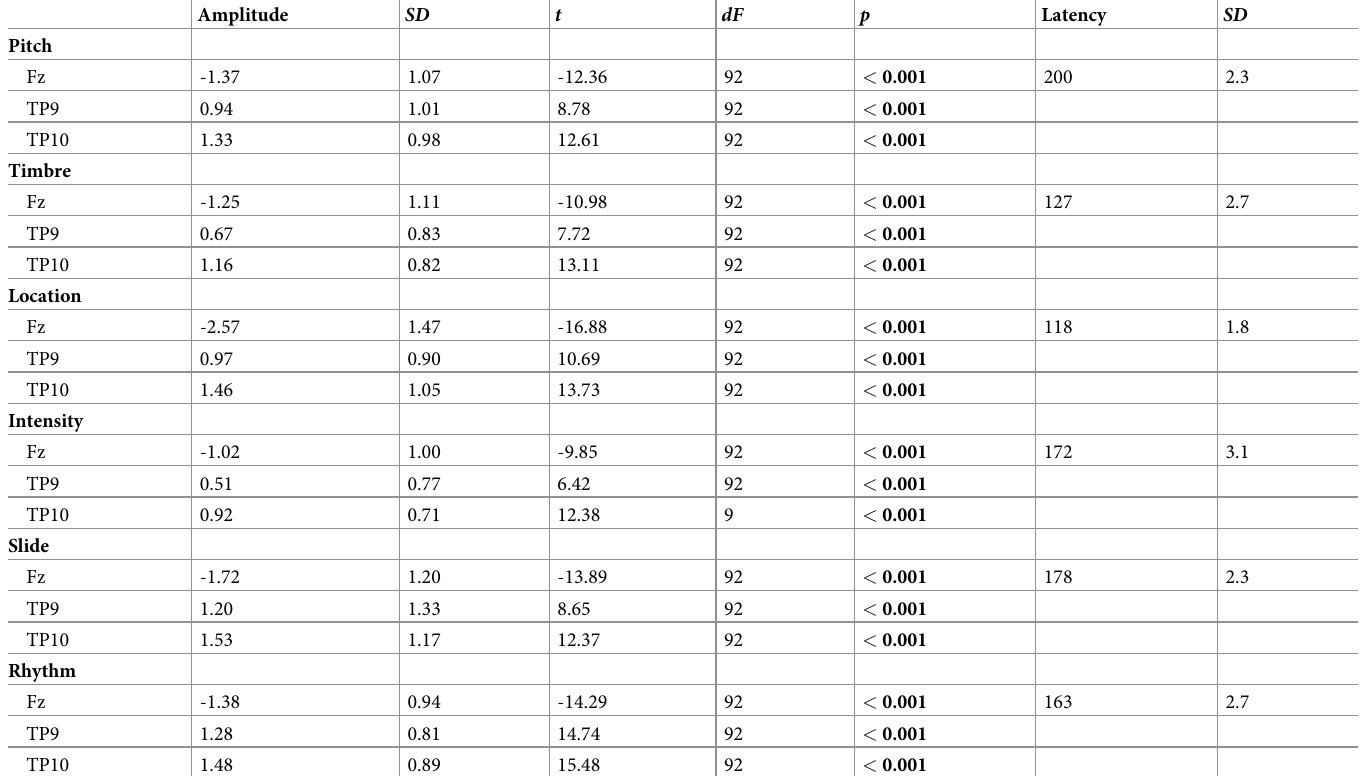
Significant p- values are shown in